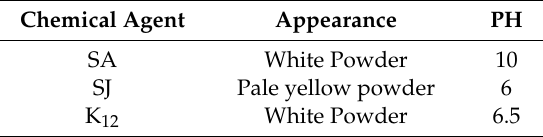
Table 3. The main characteristic of the used air entraining agents (AEAs).